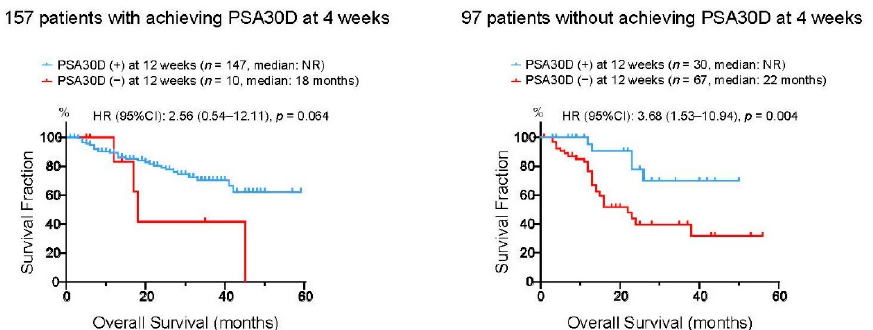
Figure 5. Kaplan-Meier curves for overall survival (OS) from the initiation of the first-line ASIs. Left panel: 157 patients with achieving >30% PSA decline (PSA30D) at four weeks were divided into two groups according to the achievement of PSA30D at 12 weeks of the treatment. Right panel: 97 patients without achieving >30% PSA decline (PSA30D) at four weeks were divided into two groups according to the achievement of PSA30D at 12 weeks of the treatment.